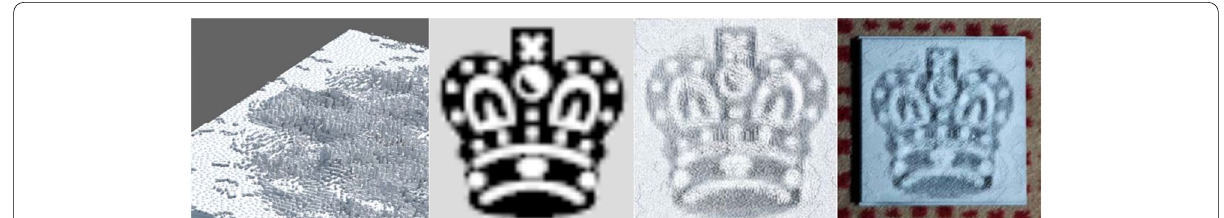
Fig. 8 From left to right are the result generated by the global method [15], the input image, the simulated result, and the manufactured result